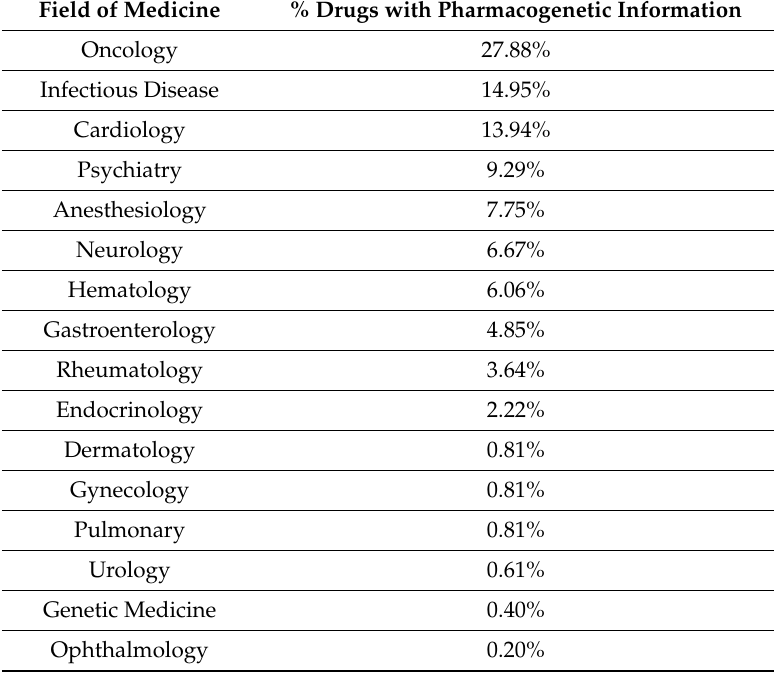
Table 2. Contributions of fields of medicine to the pharmacogenetic information in the collected